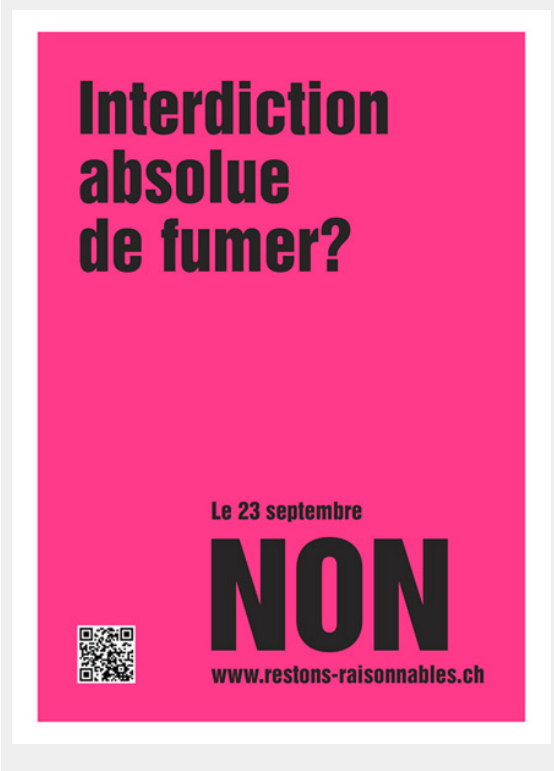
Figure 2 Main poster used by opponents to the initiative (French version).